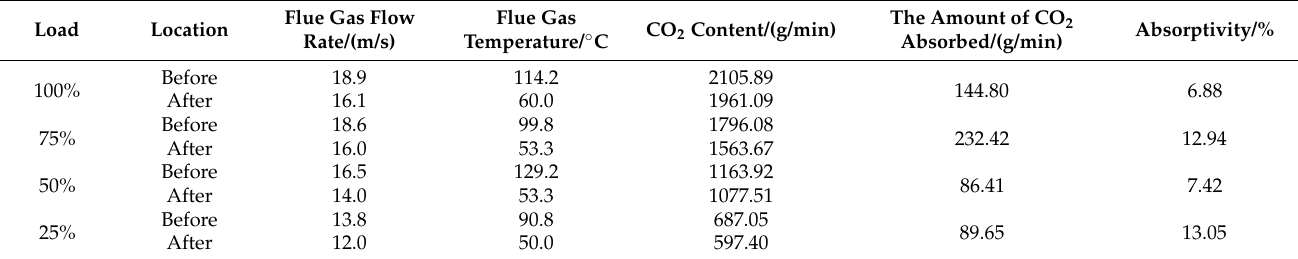
Table 9. Experimental data at n = 1500